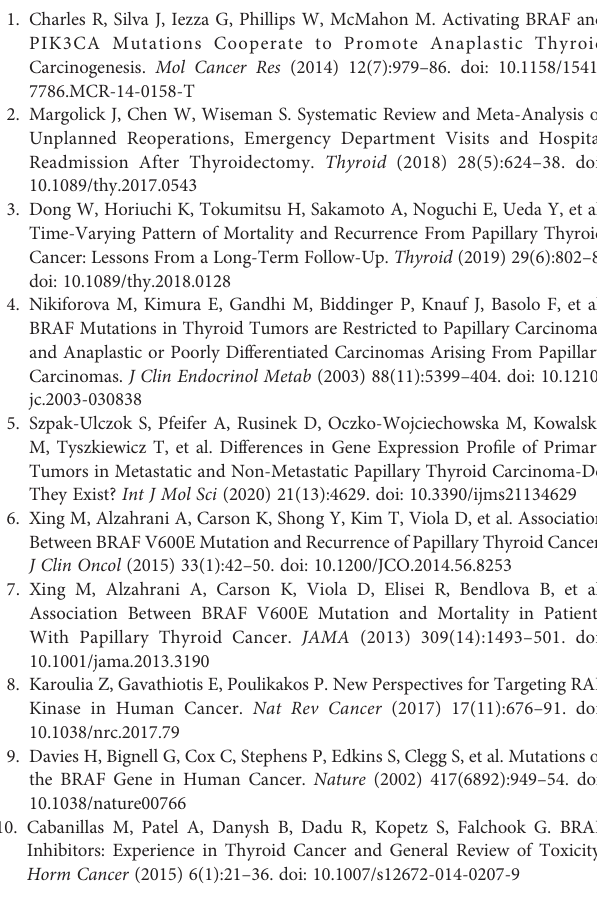
Supplementary Table 1 | ImmuneScore, StromalScore and ESTIMATEScore of the BRAF mutation group. Supplementary Table 2 | DEGs in the high and low stromal/immune/ESTIMATE score groups of the BRAF mutation group. Supplementary Figure 1 | Correlations of TME scores with PFS in BRAF- mutated PTC. Kaplan – Meier survival analysis for BRAF-mutated samples grouped